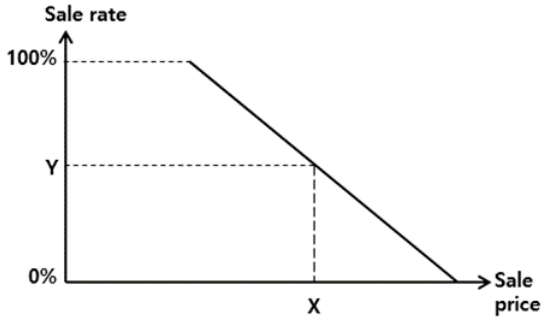
Figure 10. Elicitation of pre-sale price.